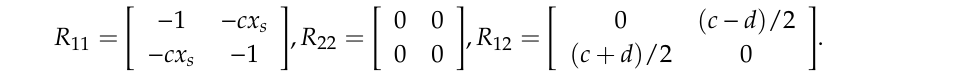
Figure 4. Inner circle (green) and elliptic (black) approximations to the cardioid